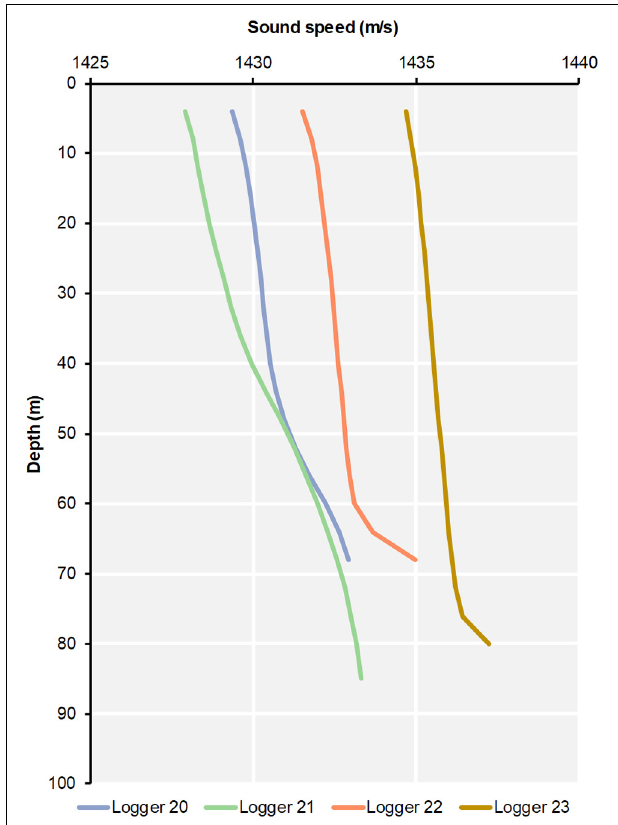
FIGURE 2 | Vertical sound speed profiles recorded in the logger deployment locations in 15.01.2014. Data source: SMHI HIROMB BS01 forecast model, provided by the